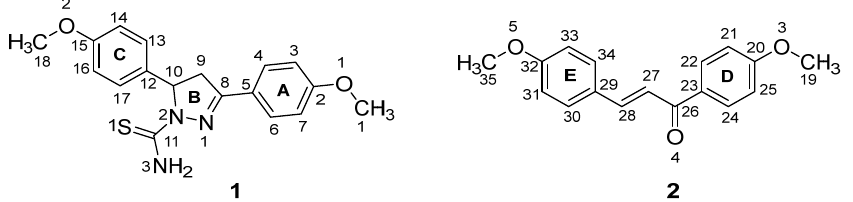
Figure 1. The molecules 1 and 2 showing the atom numbering scheme used in the discussion.